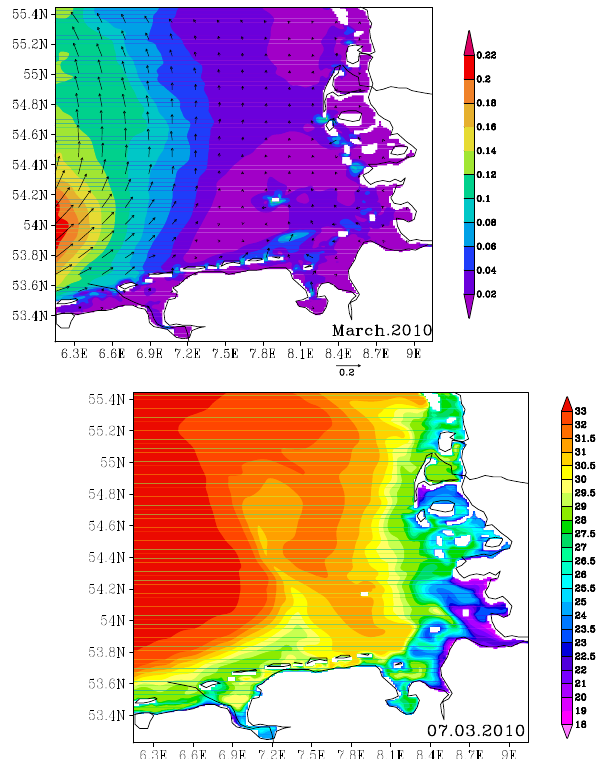
Fig. 7. Time-average of the vertically integrated circulation (in F IG . 7. Time-average of the vertically integrated circulation (in m/s) in the German Bight ms − 1 ) in the German Bight during March 2010 (a) and surface during March 2010 (a) and surface salinity (in PSU) on 07.03.2010 (b). salinity (in PSU) on 07/03/2010 (b)